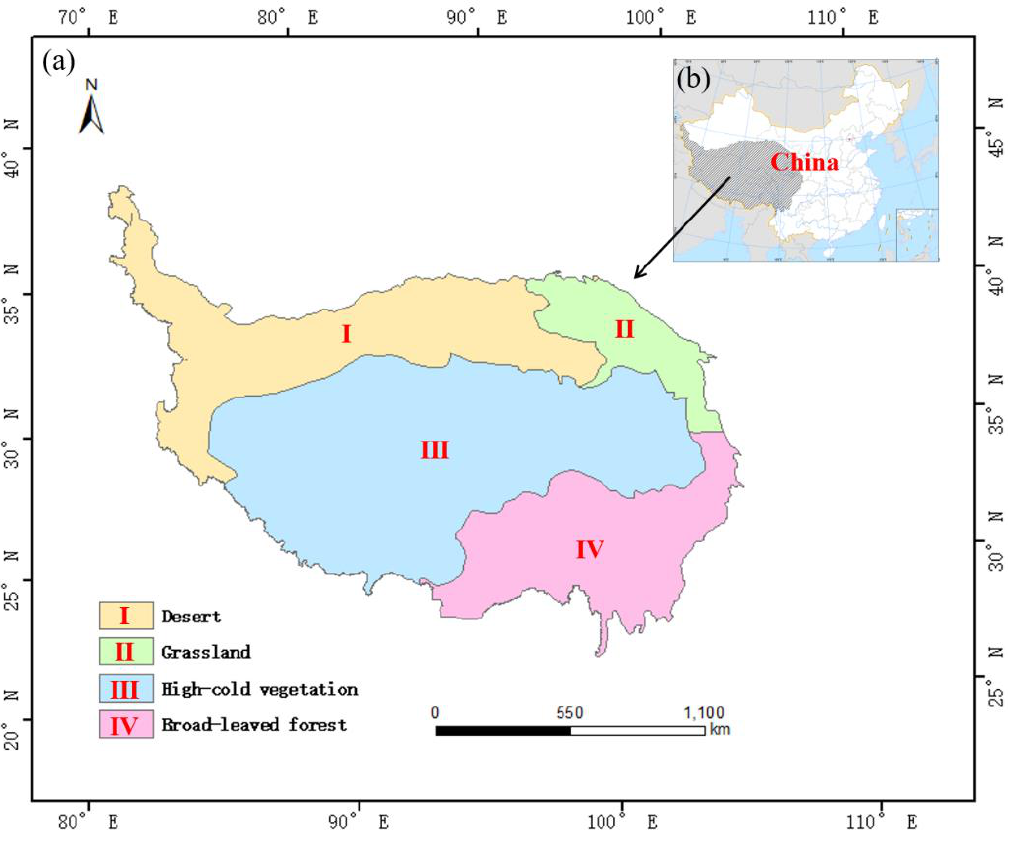
Figure 1. Vegetation regionalization of the Qinghai-Tibet Plateau (QTP) ( a ), and the location of the study area ( b ).